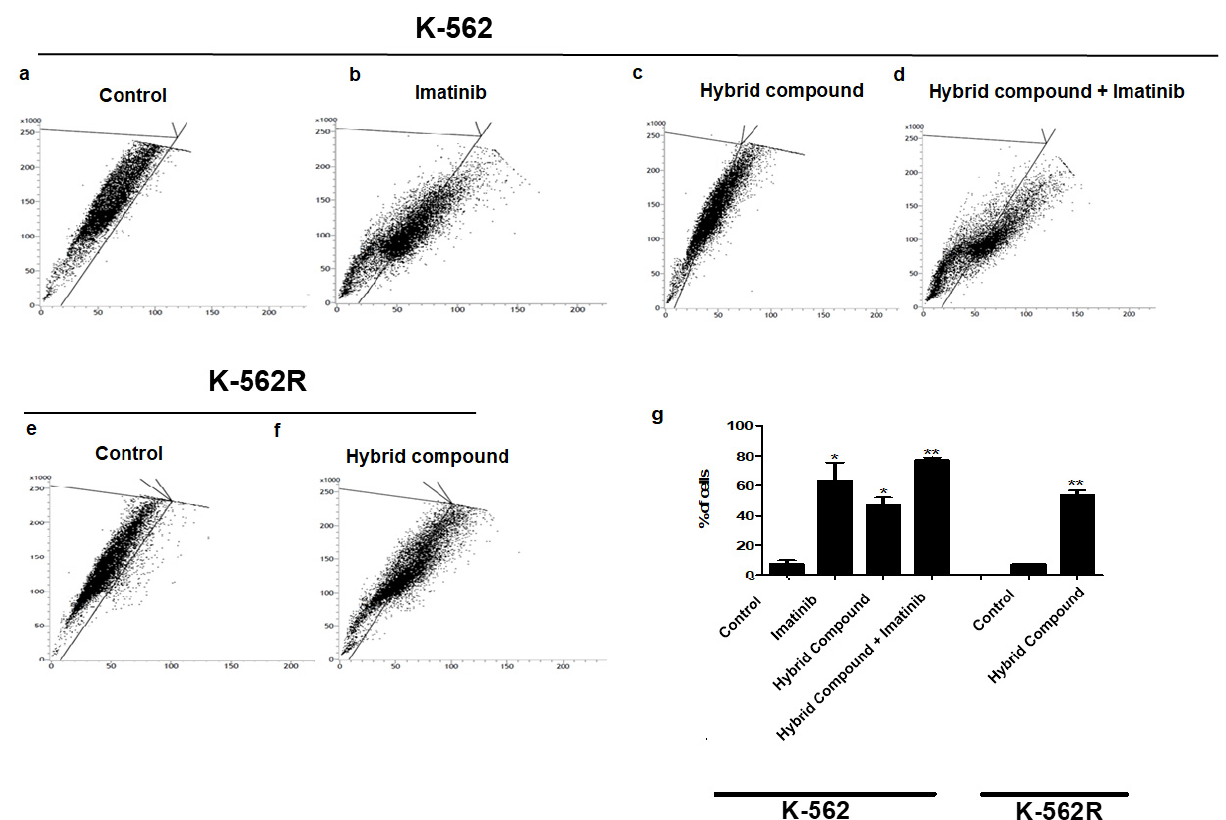
Figure 7. Autophagy observed with acridine orange (AO) staining by flow cytometry after 48 h of treatment of K-562 cells with ( a ) only RPMI-1640 medium, ( b ) imatinib, ( c ) hybrid compound and ( d ) a combination of hybrid compound and imatinib, and of K-562R cells with ( e ) only RPMI 1640 medium or ( f ) hybrid compound ( g ) Percentage of AO-positive cells are shown. Data are reported as mean ± standard deviation (SD) of three experiments (* p < 0.05; ** p < 0.01; relative to untreated control cells).